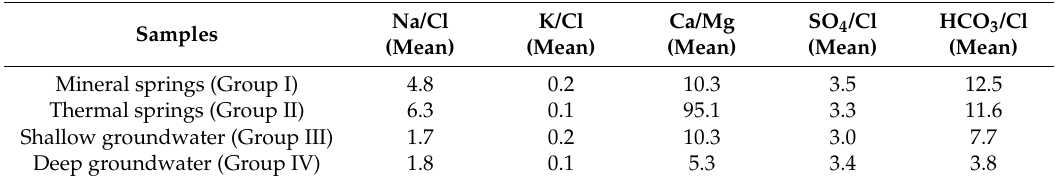
Table 2. Mean ionic ratios of the water samples.